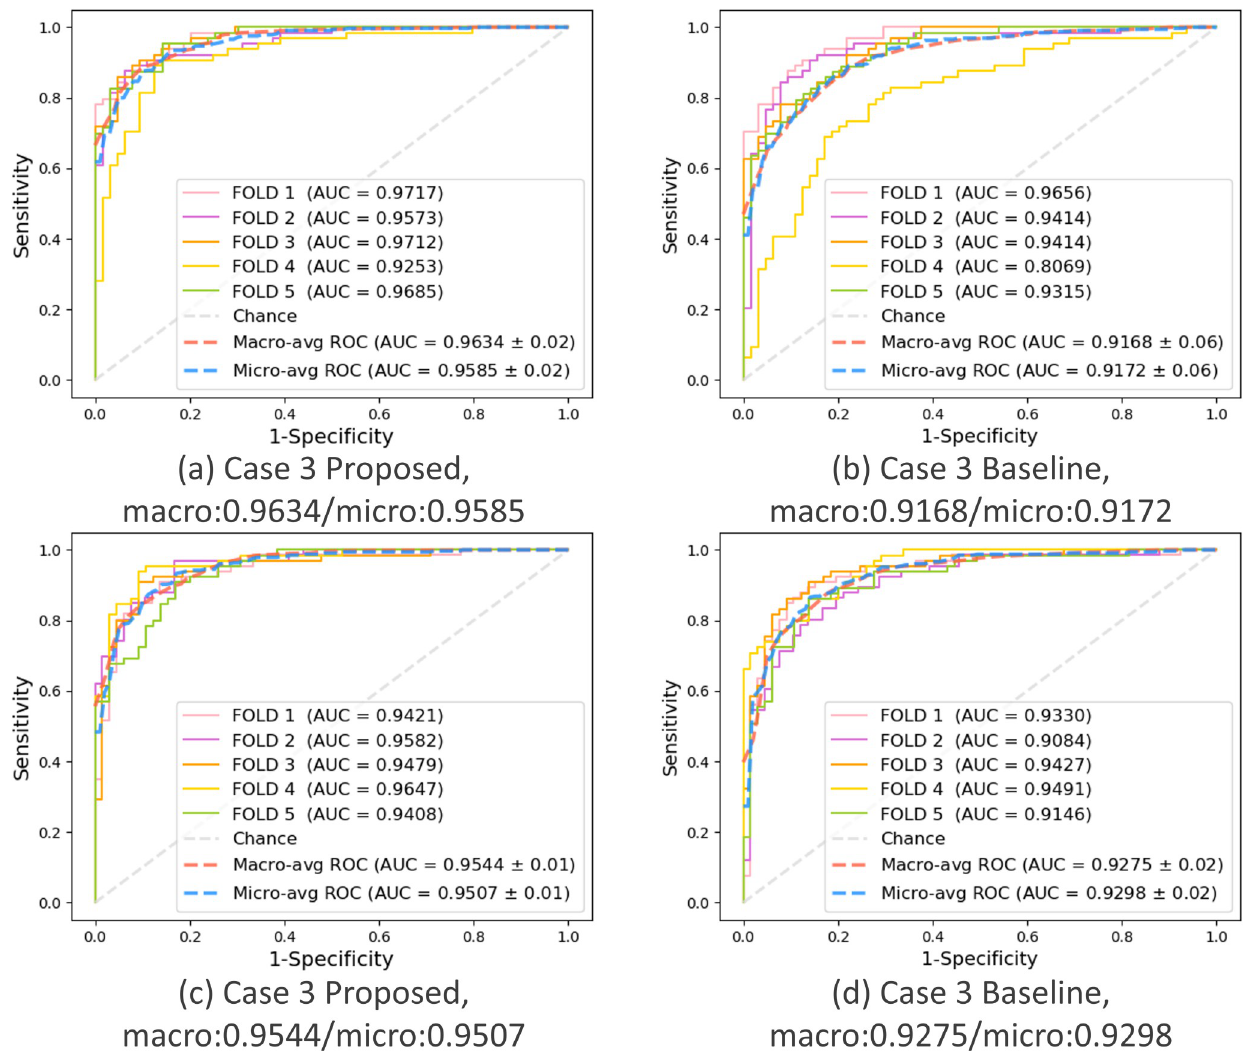
Fig 7. Case 3: Hypokinetic dysarthria vs. ataxia. Comparison of the performance between the proposed and baseline schemes in terms of AUC. (a) Autumn + proposed, (b) Autumn + baseline, (c) Number + proposed, (d) Number + baseline.